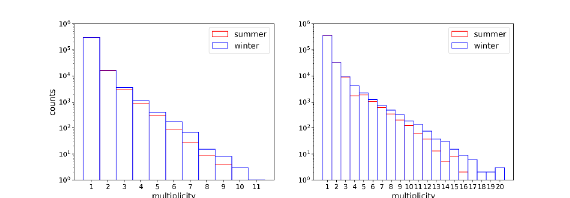
Figure 4: Accumulated multiplicity distribution consid- ering all the energy showers (10, 30, 50, 100, 500, and 1000 TeV) for zenith angle showers of (a) θ = 30 ◦ and (b) θ = 50 ◦ ) for summer (red) and winter